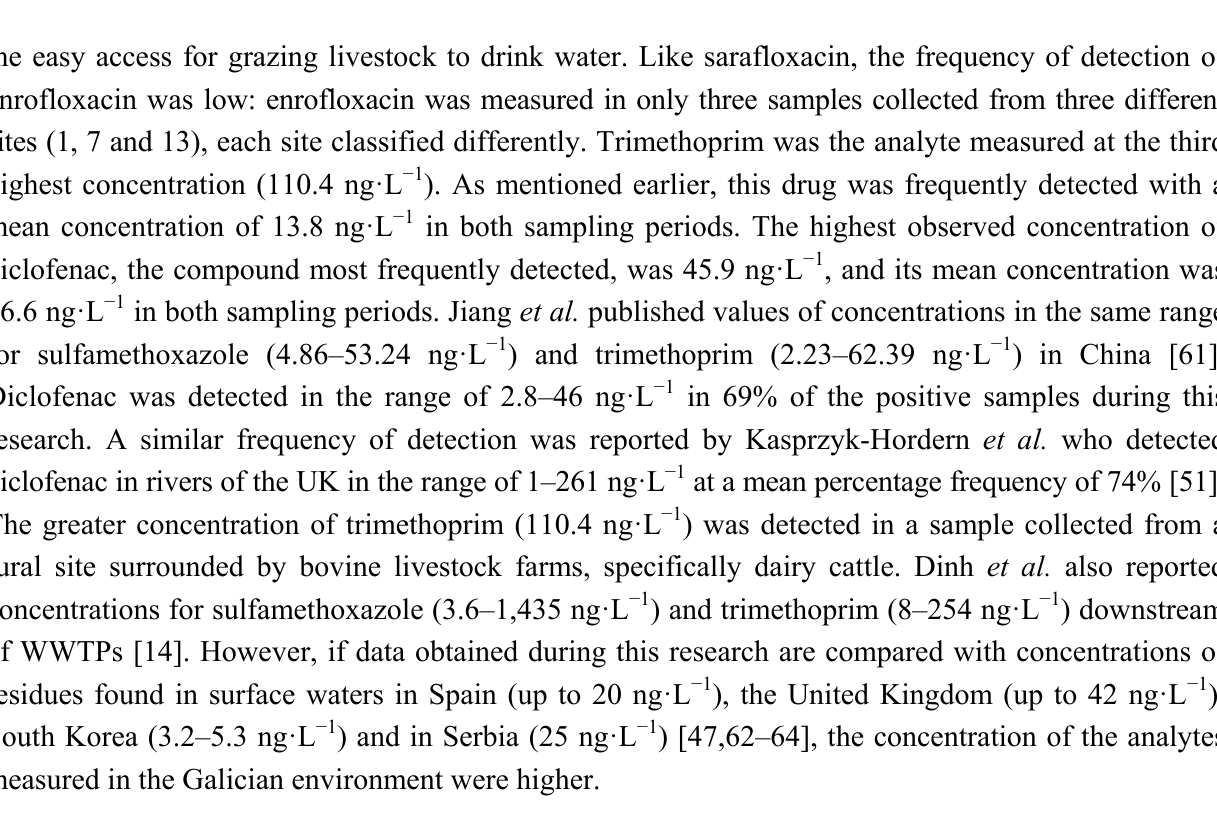
Table 6. Maximum, minimum and mean concentrations of the selected drugs detected in Spanish surface water and number of time detected in the